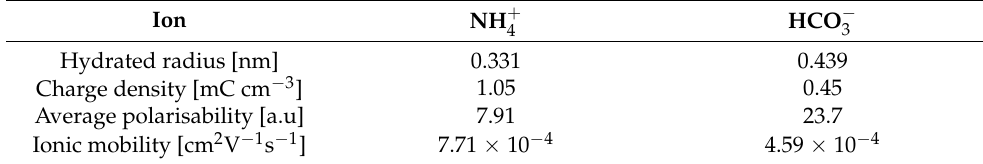
Table 3. Properties of the ions considered in this